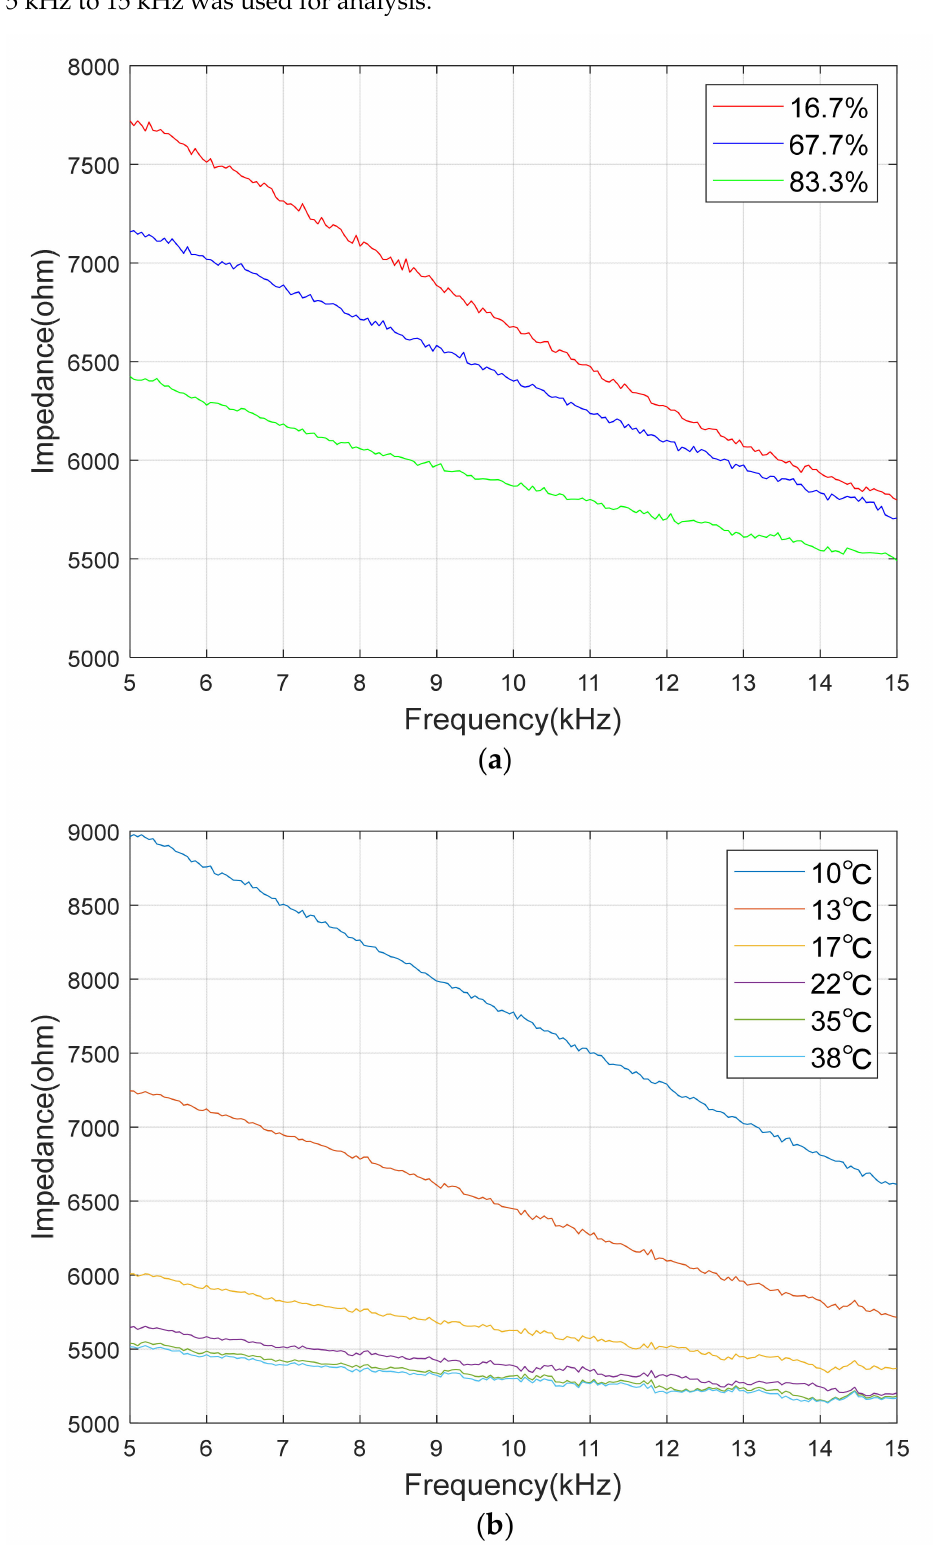
Figure 15. Measured impedance graph: ( a ) Impedance graph by different mixture ratio at 13 ◦ C; ( b ) Impedance graph by different